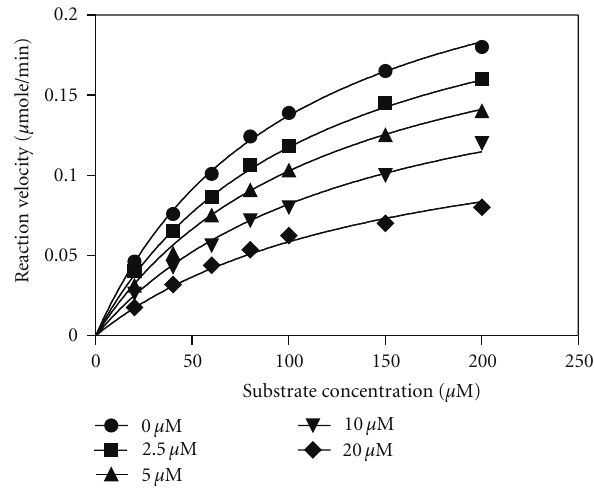
Figure 3: Kinetic assay plot for the inhibition of the NS2B-NS3pro from dengue virus by PG-1 peptide. This assay was carried out using increasing concentration of inhibitor while all other conditions were kept constant. The data was analysed by Michaelis-Menten model under nonlinear regression curve fit in GraphPad Prism 5 software. The peptide concentrations were 0, 2.5, 5, 10, and 20 μ M. The maximum enzyme velocity decreased from approximately threefold when PG-1 concentration was 20 μ M.